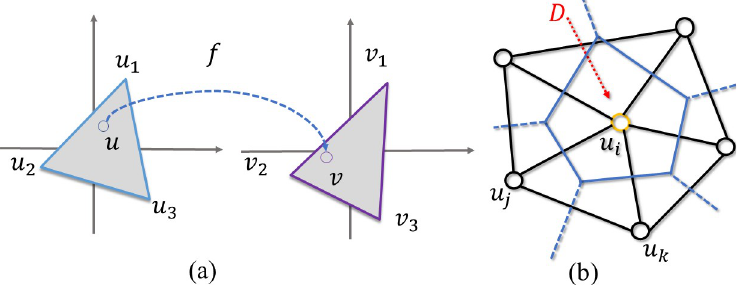
Fig 5. Illustration of a mapping function and the divergence computation. (A) An illustration of the mapping function in the discrete domain, and (B) the divergence approximation for a vertex.